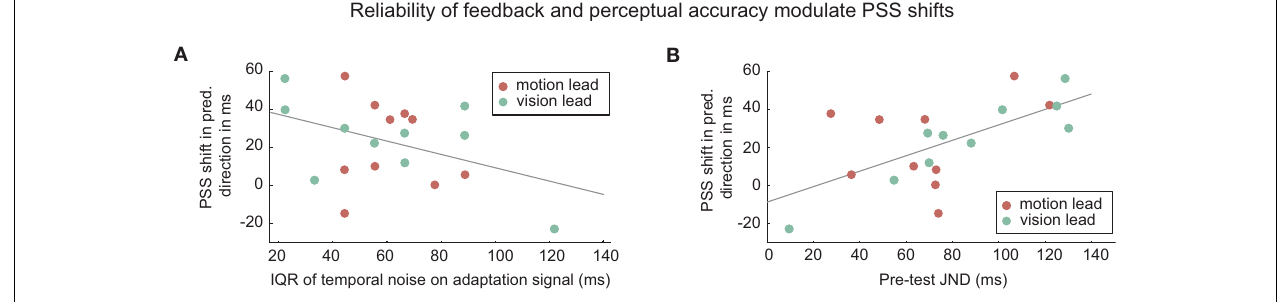
FIGURE 5 | Reliability of feedback and perceptual accuracy modulate PSS shifts. PSS-shifts in the predicted direction (i.e., negative for vision-lead) as a function of (A) temporal accuracy of recalibration signal and (B) perceptual precision (pre-test JND). Grey solid lines are least square regression